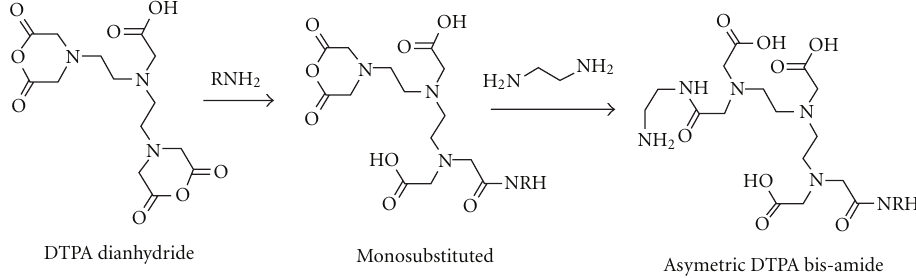
Figure 1: Scheme for mixed DTPA bisamide with free amine for